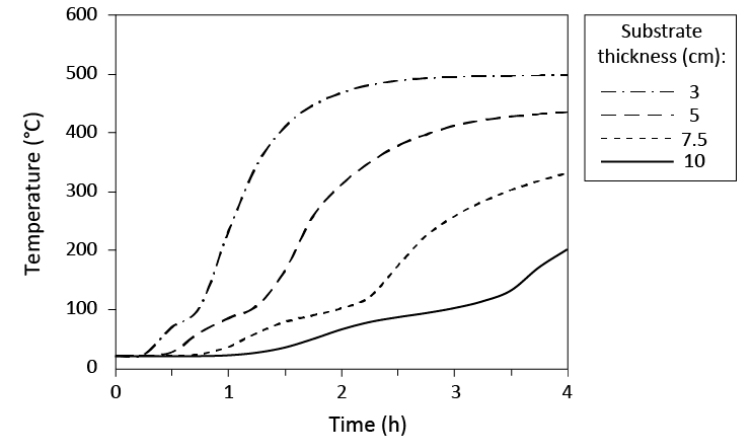
Figure 17. Temperature evolution at the deck (steel) level in the assembly exposed to 200 kW/m².